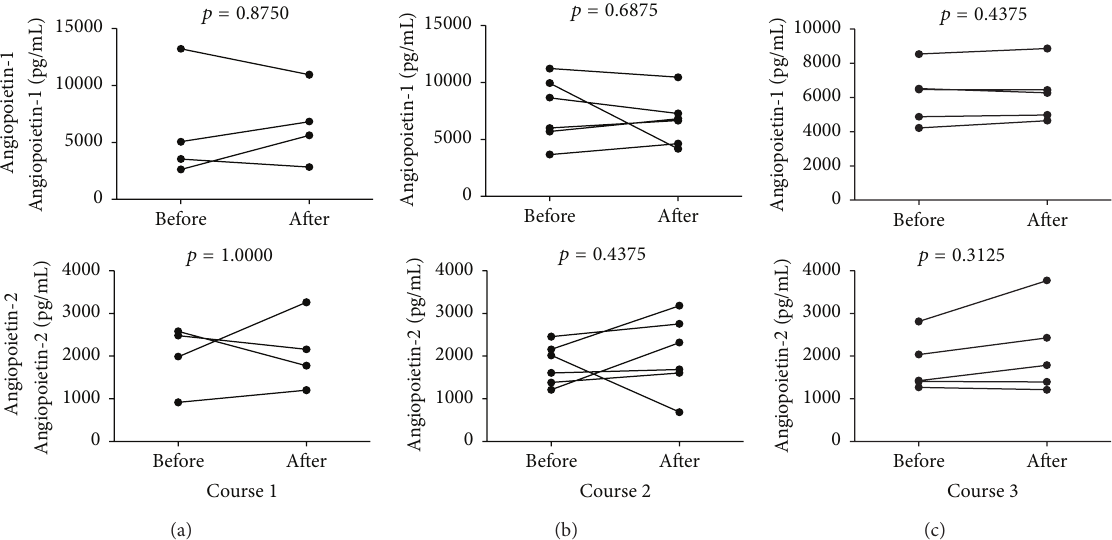
Figure 3: Time course changes in Ang-1 (upper row) and Ang-2 (bottom row) plasma levels in pediatric patients with MD after (a) course 1, (b) course 2, and (c) course 3 of G-CSF